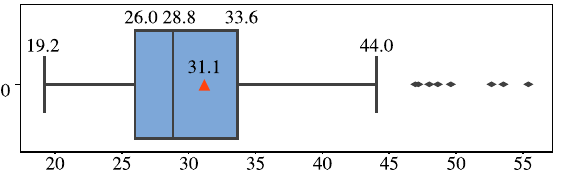
Figure 11. The boxplot of RMSE values.